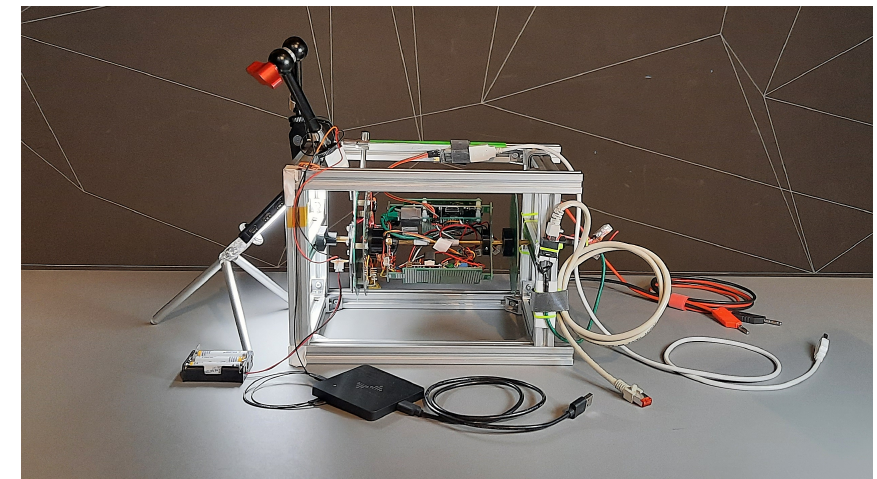
Figure 1: The prototype as we used it to test power transfer and bidirectional commu- nication between stator and rotor. This picture shows the proof-of-concept prototype’s configuration that we used for accelerometer characterization (Section 6) without the vertical security mesh struts that connect the circular top and bottom outer